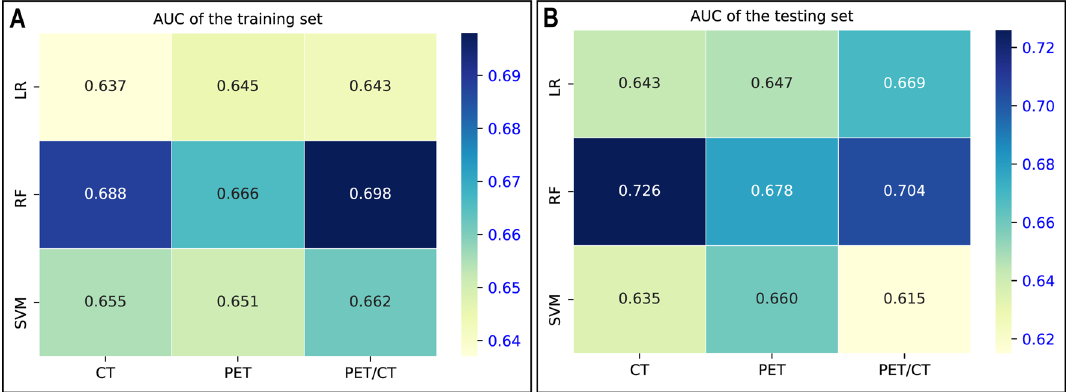
Fig. 3 The AUC values of the nine radiomics models in the training set ( A ) and testing set B . LR logistic regression, RF random forest, SVM support vector